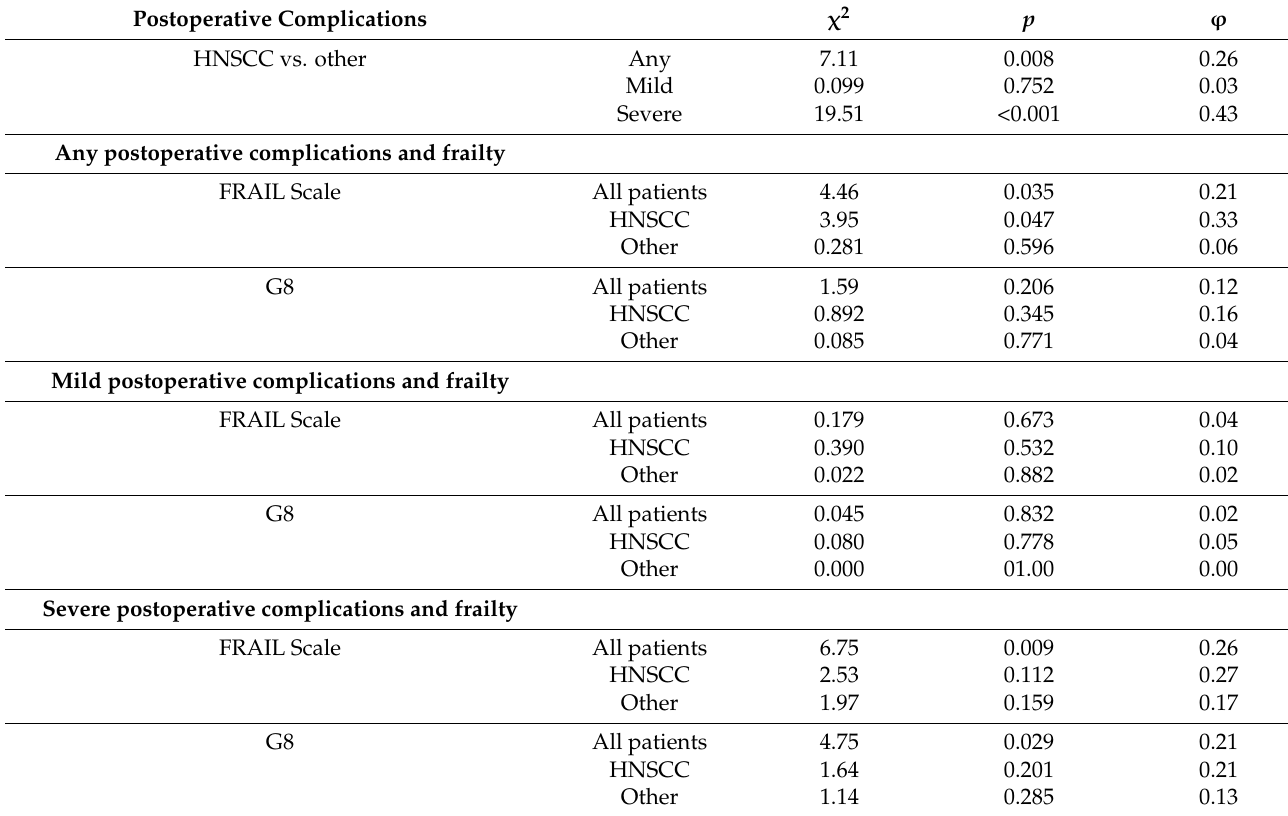
Table 3. χ 2 test for occurrence of postoperative complications and occurrence of postoperative complications depending on frailty.